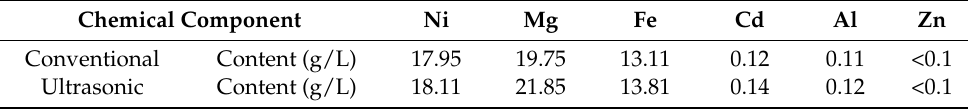
Table 4. The main chemical components in the leached